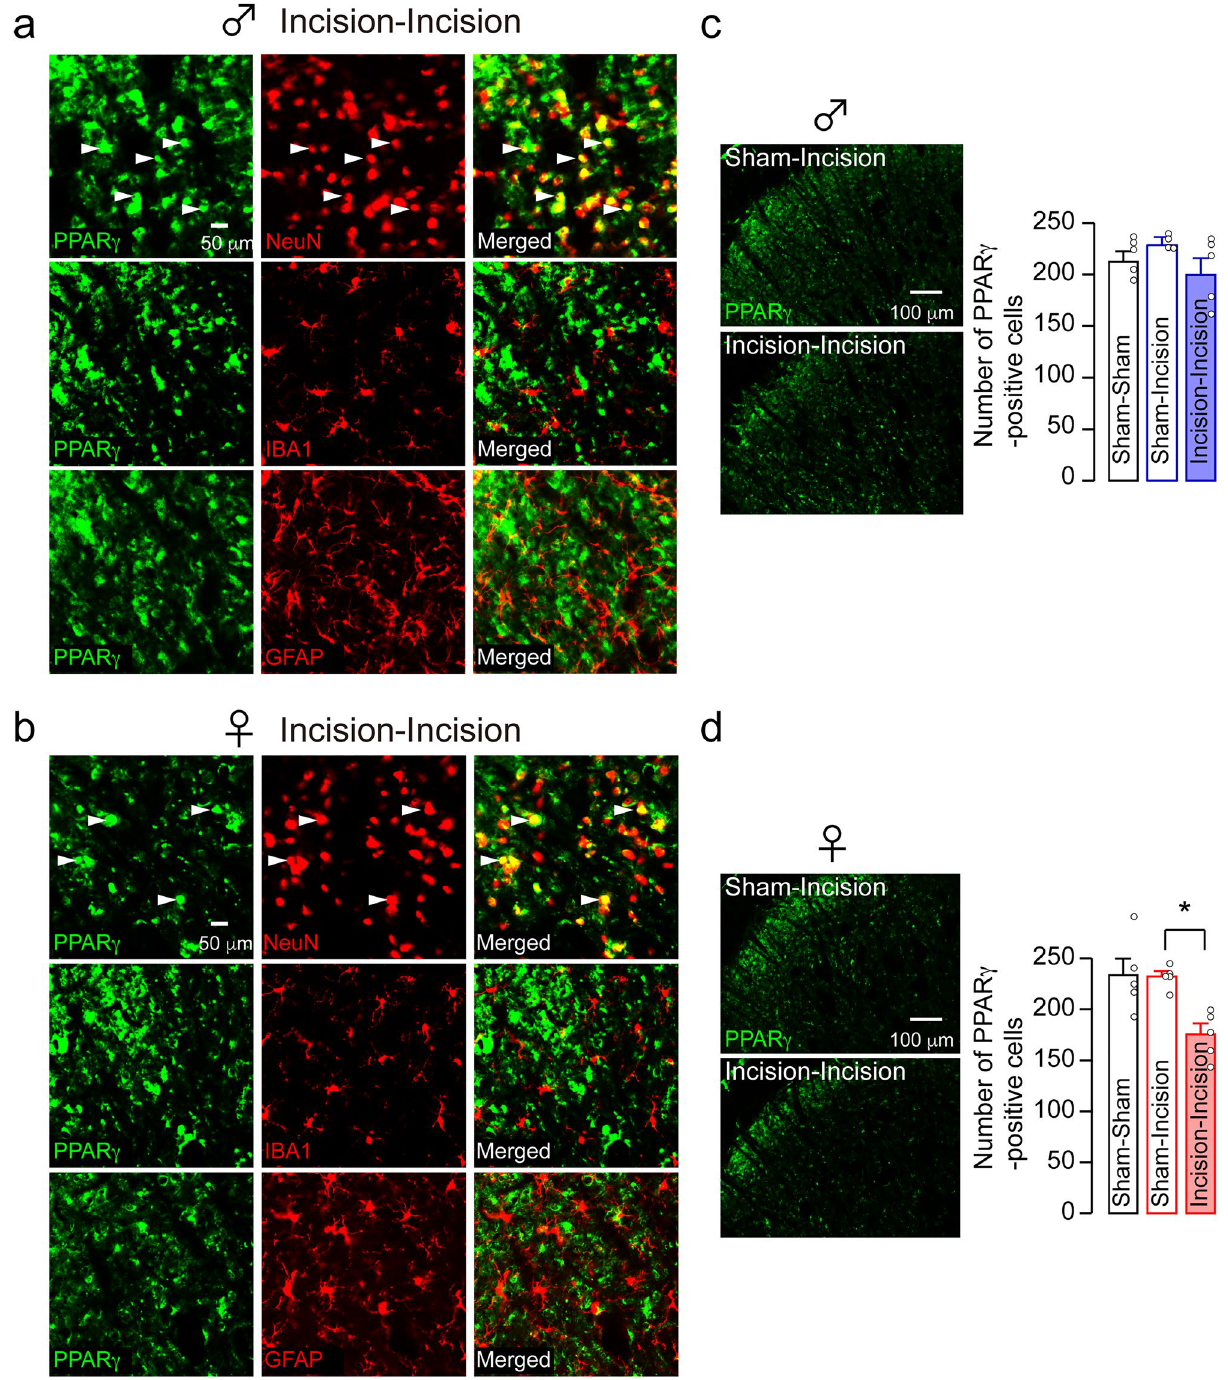
Figure 4. Expression patterns of PPARγ in the Vc. ( a, b ) The images showing PPARγ, NeuN, IBA1, and GFAP immunofluorescence in the Vc of the Incision-Incision group in male rats ( a ) and female rats ( b ) 10 days after whisker pad skin re-incision. Arrowheads indicate PPARγ and NeuN double-positive cells. Scale bars = 50 µm. ( c, d ) The representative images of PPARγ immunofluorescence in the Vc of male ( c ) and female rats ( d ) 10 days after whisker pad skin re-incision. The columns represent the mean number of PPARγ-positive cells in the Vc 10 days after re-incision. Scale bars = 100 µm. Data represent the mean ± SEM. n = 5 in each, one-way ANOVA post hoc Tukey’s test, * p = 0.0105 in ( d